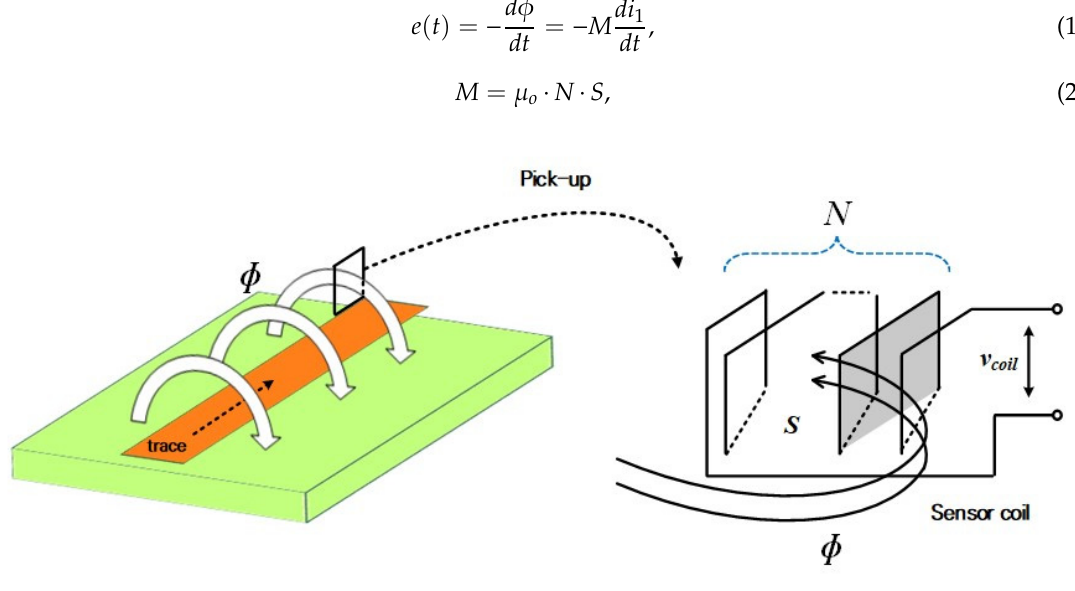
Figure 1. Schematic of the pick-up coil.